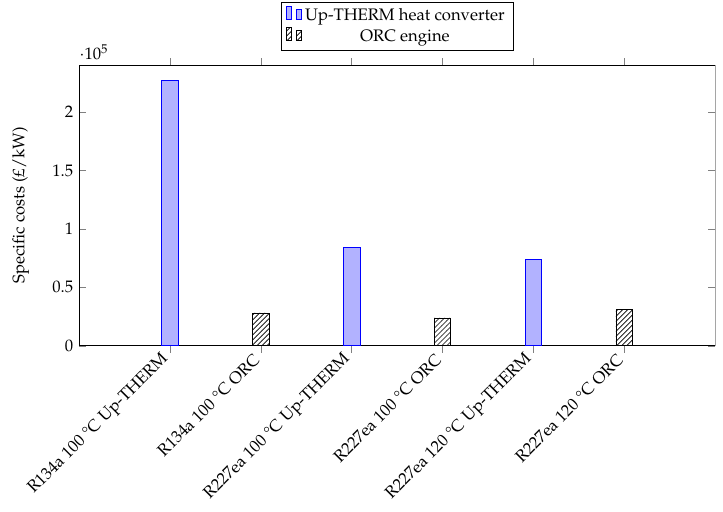
Figure 15. Specific costs for the Up-THERM heat converter and equivalent ORC engines for R134a and R227ea as working fluids at different heat-source